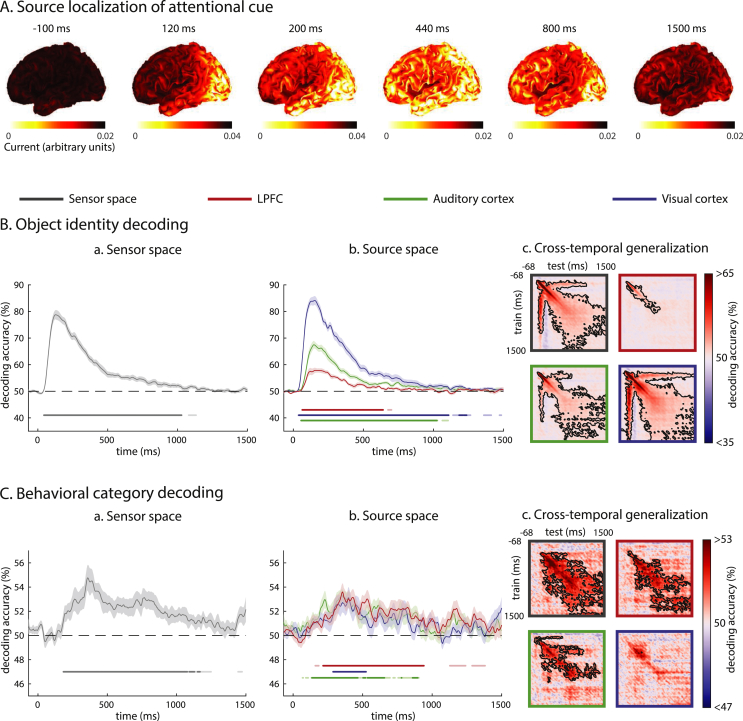
Coding of visual and behavioral properties of 1-item displays (A) Source localization of EEG/MEG response to visual presentation (including both single-item and multi-item displays) at representative time-points. (B) Decoding time-courses of object identity, in (a) sensor and (b) source space, when training/testing using matched time-points, and (c) generalizing across training/testing times. Dark colored dots beneath the decoding curves show times where decoding is significantly above chance for each condition (p < 0.05), corrected for multiple comparisons along the diagonal of the cross-temporal generalization matrix; faint colored dots represent additional time-points where the diagonal of the cross-temporal generalization matrix is significant when corrected for multiple comparisons across the whole matrix. Translucent bands represent standard error of the mean. Black contours in cross-time matrices indicate regions of significant decoding (p < 0.05). Significance is corrected for multiple comparisons across time using TFCE and permutation testing. (C) Decoding time-courses and cross-temporal generalization for behavioral category information. Object identity decoding emerged earlier than behavioral category decoding. Visual cortex showed the highest object decoding accuracy, while ROIs were comparable in their strength of behavioral category representation.